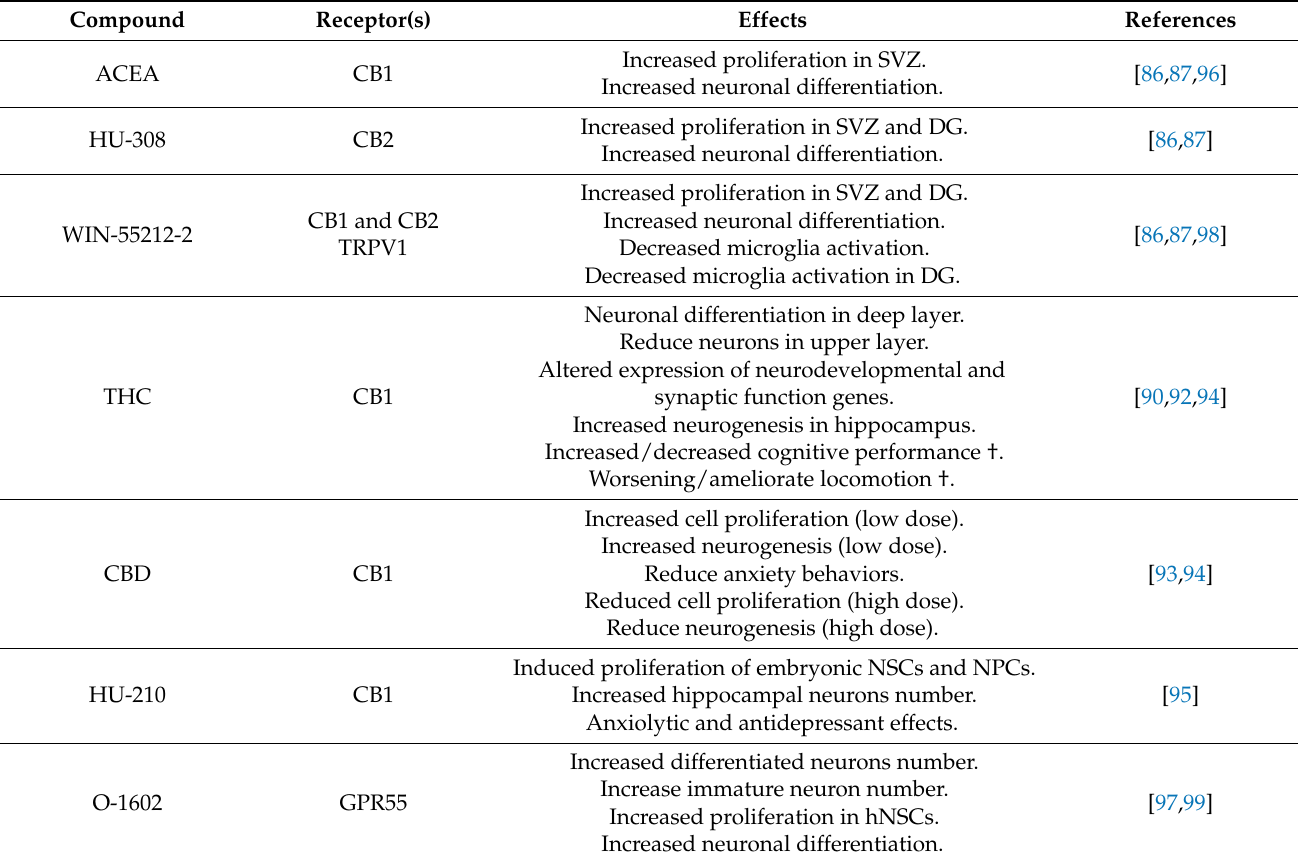
Table 2. Proof-of-concept of cannabinoids capacity to induce neurogenesis, with the receptor(s) where they are supposed to exert the effects described in the selected